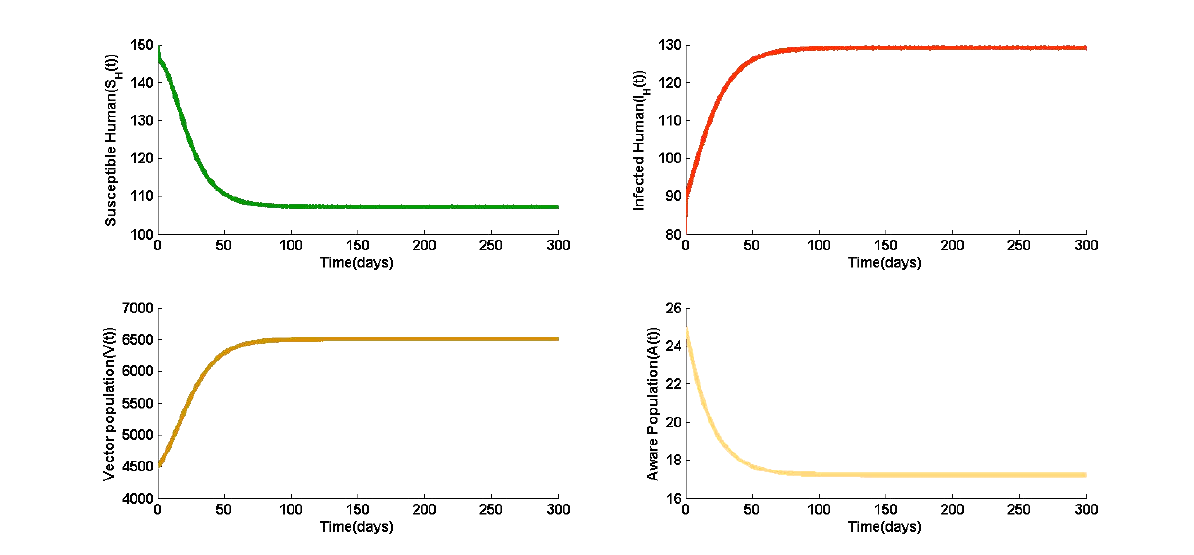
Fig. 3. Behavior of different population for R 0 > 1, when the system attains its endemic